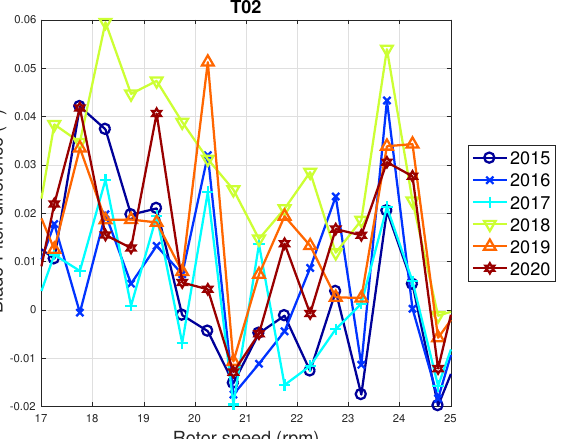
Figure 16. Binned rotor speed–blade pitch curve for T02 in WF2: the curves are reported in the form of difference with respect to the year